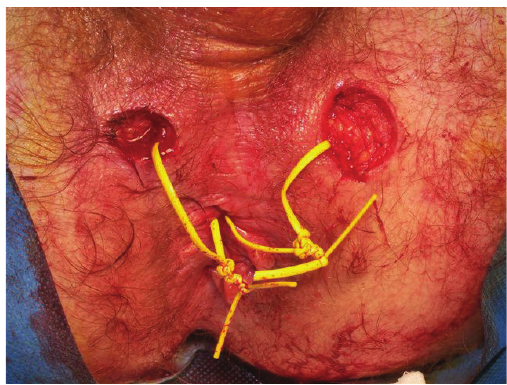
Figure 3: An example of double seton placement in an extra exter- nal opening.